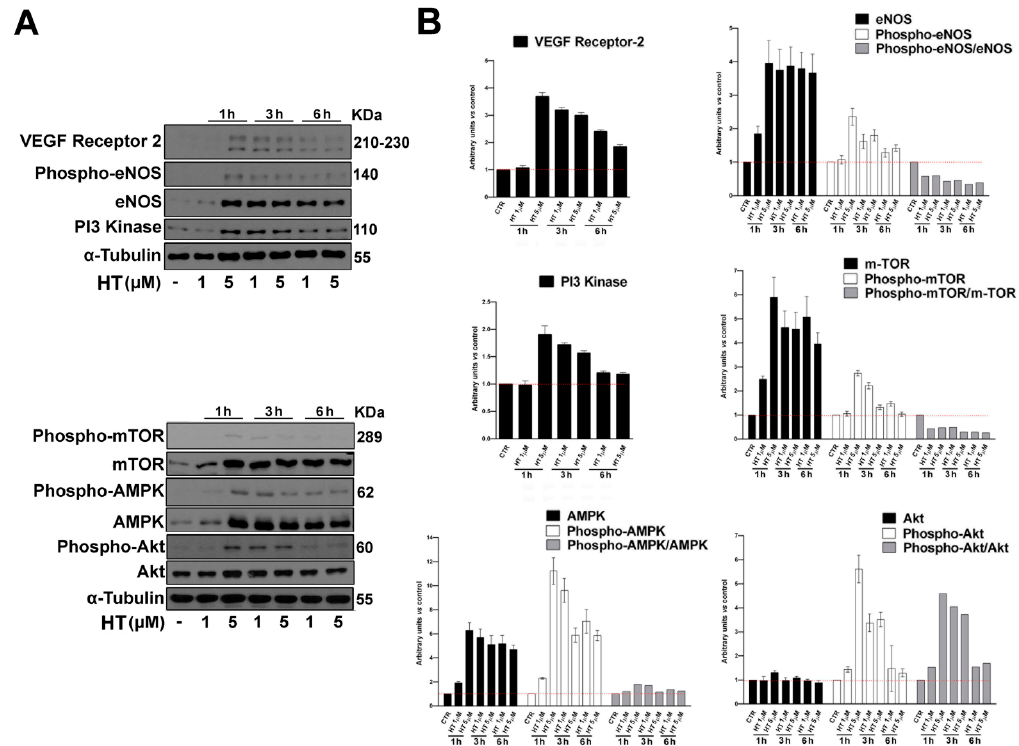
Figure 5. HT induces angiogenesis proteins expression in HUVEC cells. ( A ) Western blot analysis of VEGF Receptor-2, Phosho-eNOS, eNOS, PI3-Kinase, Phospho-mTOR, m-TOR, Phospho-AMPK, AMPK, Phospho-Akt and Akt in whole cell extracts from HUVECs cultured for 1 h, 3 h and 6 h in the presence of the indicated concentrations of HT. α -Tubulin was used as control of protein loading. The panel shows a representative Western blot of three different experiments performed with similar results. ( B ) Histograms represent mean (± SD) in densitometry units of scanned immunoblots from three different experiments.